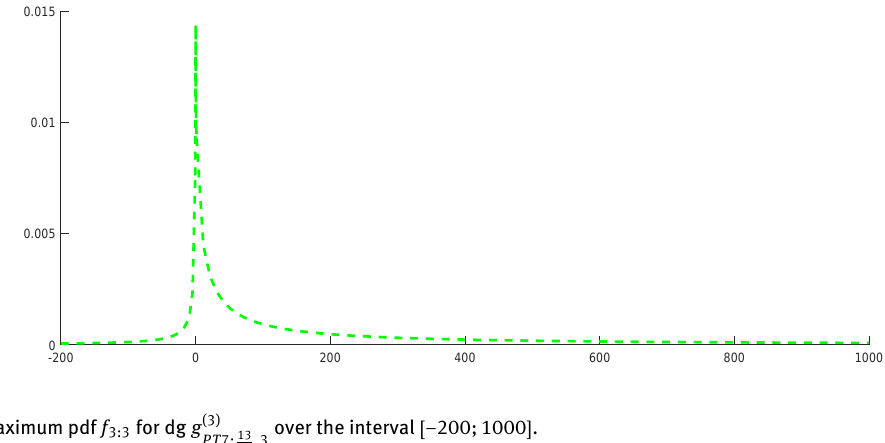
Figure 8: Maximum pdf f 3:3 for dg g (3)